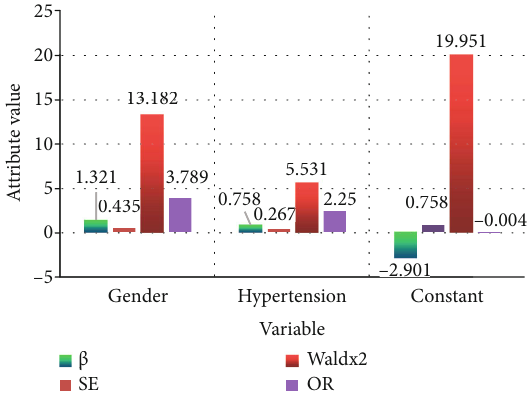
Figure 4: Holter in patients with negative coronary